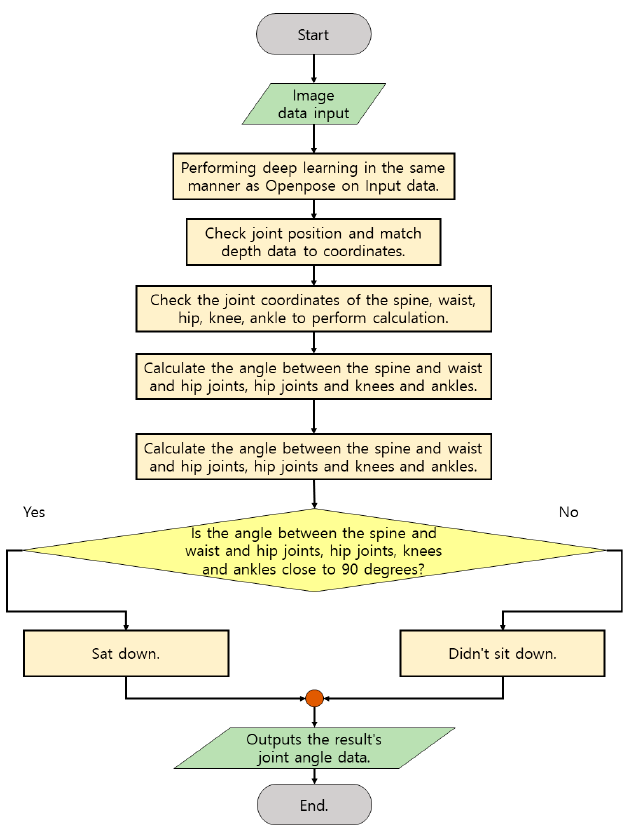
Figure 7. Flow chart image performed to check the joint angle of the leg.